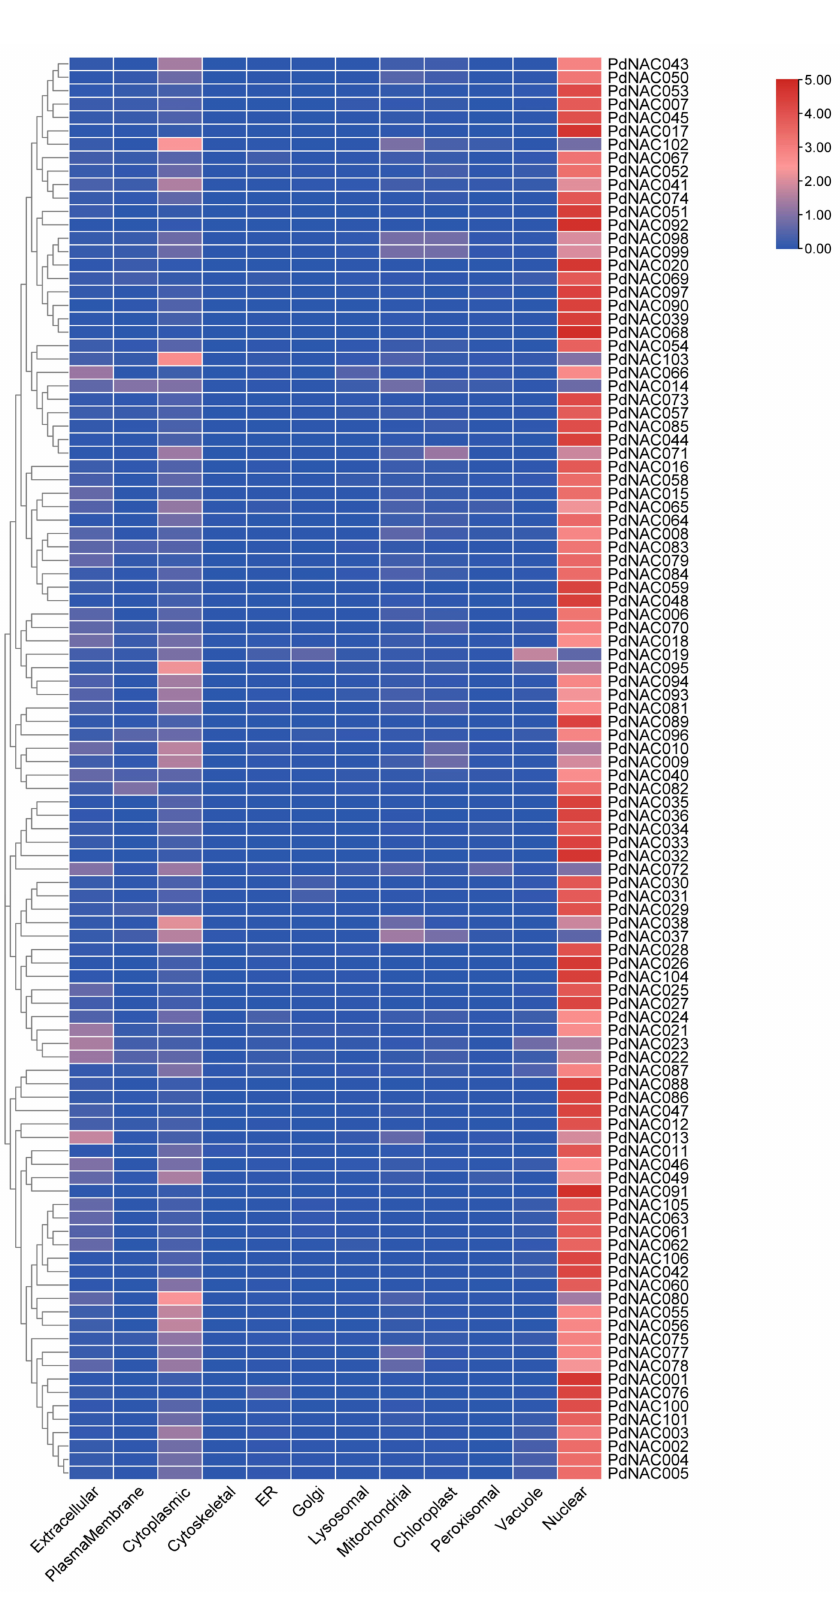
Figure 9. Subcellular localization prediction of PdNAC . Subcellular localization of the PdNAC is shown along with the phylogenetic tree of PdNAC . Majority of the PdNAC are localized in the